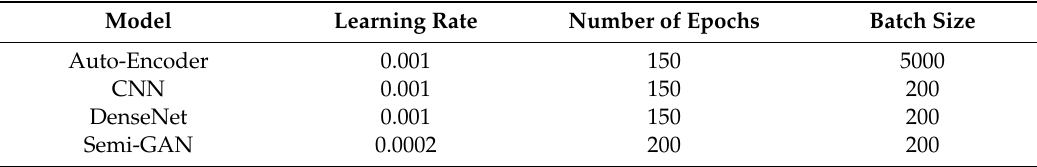
Table 4. The detailed parameter settings of deep